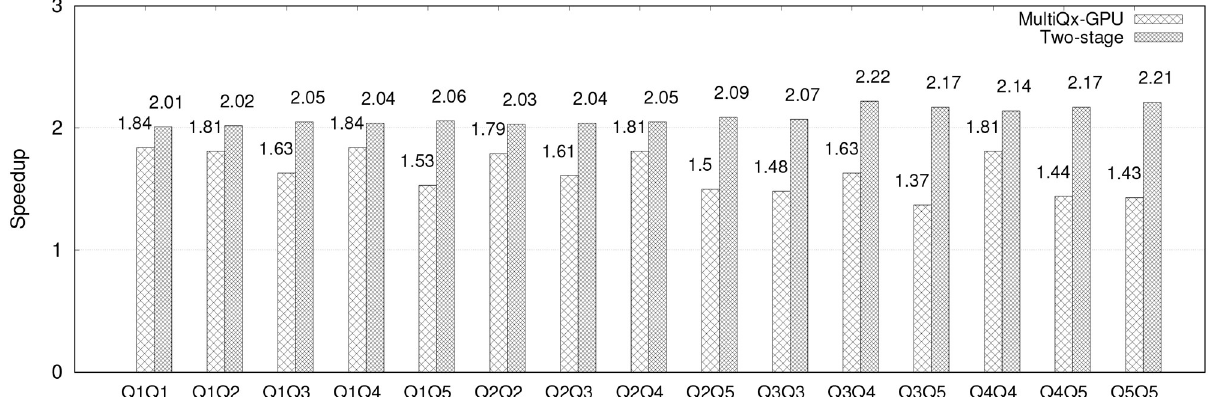
Fig 9. Speedup of two queries combinations that MultiQx-GPU Optimization and Two-stage Model over sequential solution.